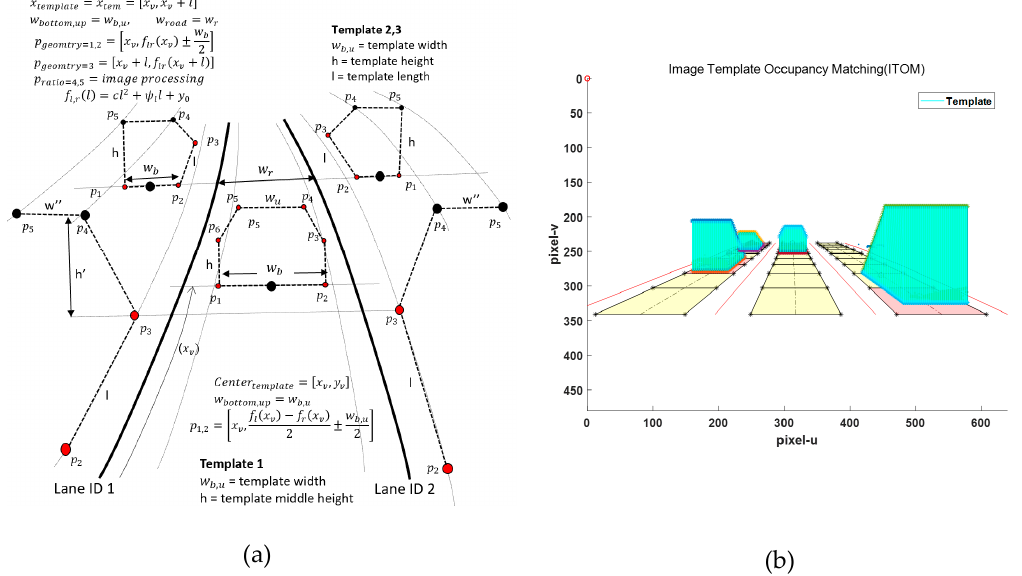
Figure 9. Image template occupancy matching (ITOM) concept plot, ( a ) template design, ( b ) search base template and match on image frame.